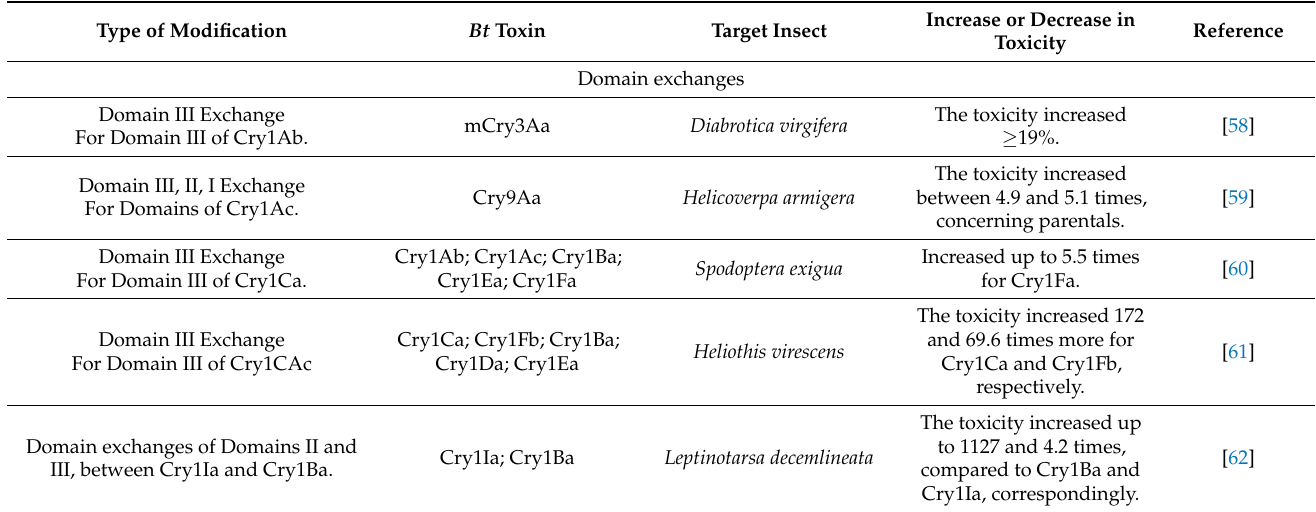
Table 2. Modifications made to Bt toxins to improve their